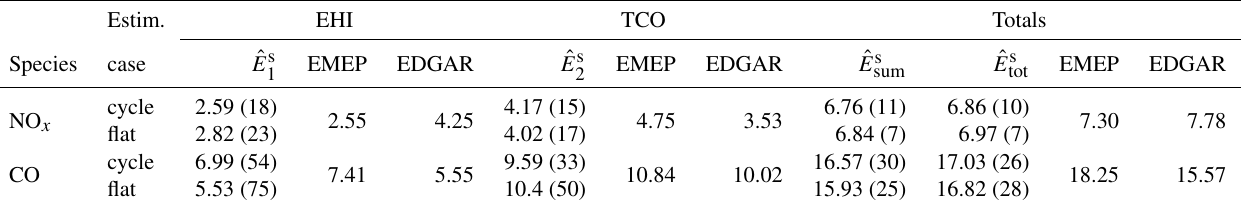
Table 1. The optimal estimates of the anthropogenic NO x and CO emissions (Tg NO 2 and Tg CO, respectively) from the study region. The numbers in brackets represent the one-sided 68.3% confidence intervals (in % relative to the respective optimal estimate). Estim. EHI TCO